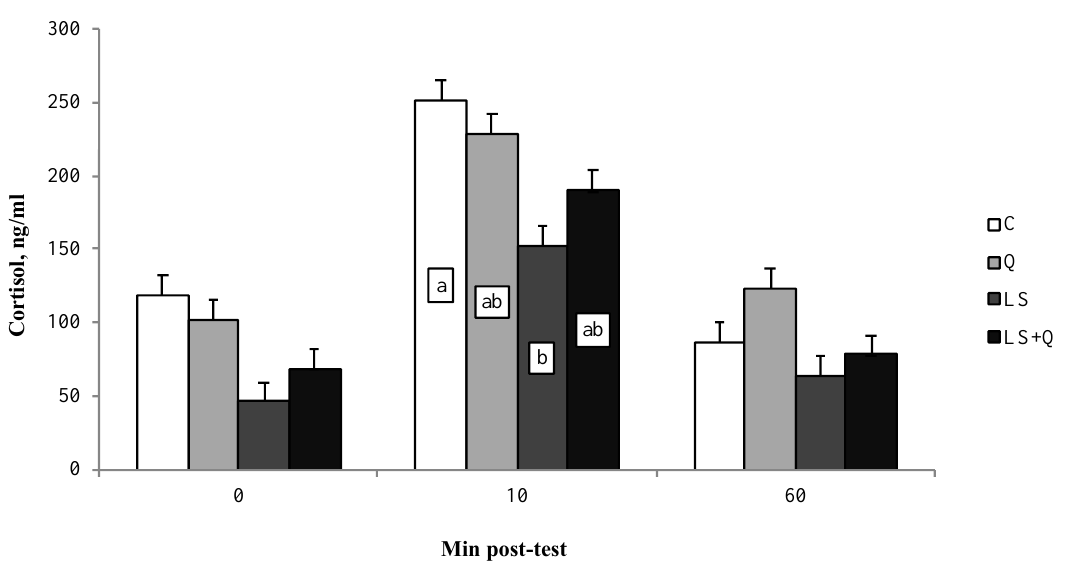
Figure 3. Plasma cortisol production (Least Squares means ± SEM) measured immediately before and then at 10, and 60 min post loading test in lambs as affected by different diet supplementation (C = control; LS = linseed; Q = quinoa seed; LS + Q = linseed + quinoa). a,b different letters differ among feeding treatments within a sampling day ( p < 0.05).